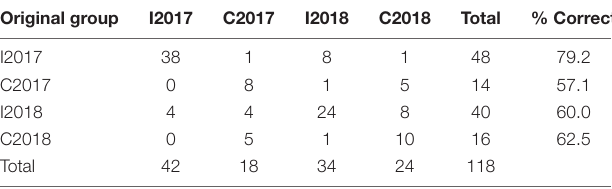
TABLE 5 | Confusion matrix derived by the CAP analysis based on the Bray–Curtis similarity matrix of the molluscs assemblages, and indicating the percentage of correct placement of each replicate of the two surveys. I: Impact; C: